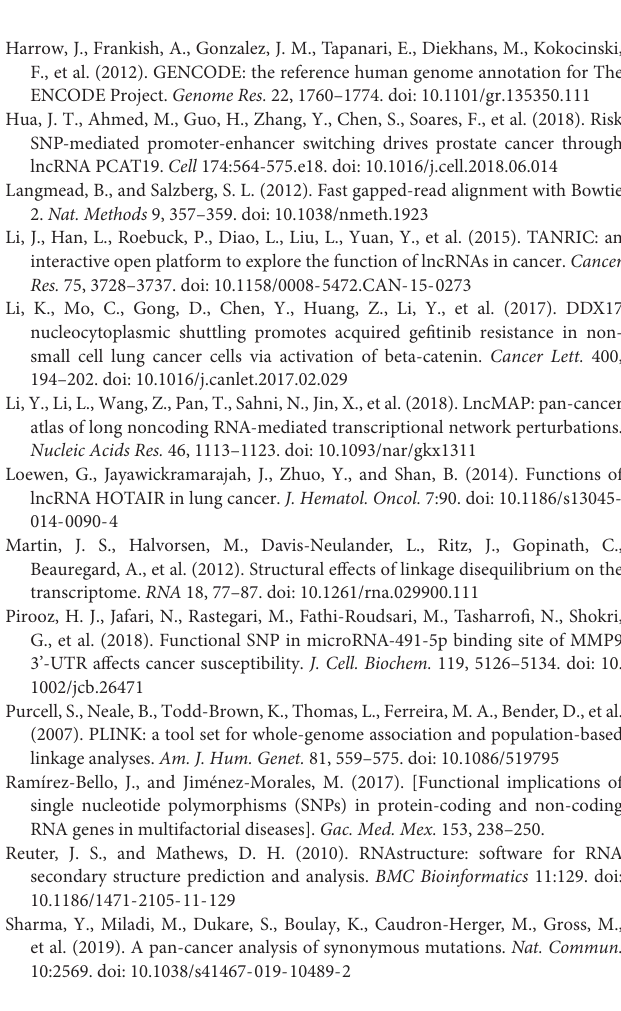
FIGURE S1 | The robust analysis of RNAsmc score. Blue and red lines indicate the differences between WT and MT lncRNA transcripts, respectively. FIGURE S2 | The permutation rules and significance evaluating of RS1, RS2, respectively. (A) Permutating flanking sequence in random way, and keeping WT and MT SNP allele unchanged. The sequence in blue shadow represented the changed content in RS1. (B) Building the background distribution for RS2. The base in red shadow showed it altered in each iteration. (C) The significance of lncRNA structural heterogeneity using RS1 and RS2. Red dot indicated that the changes were significant both in RS1 and RS2. TABLE S1 | LD SNPs mapping on lncRNA transcripts. TABLE S2 | The analysis of lncRNA structural heterogeneity induced by SNPs. TABLE S3 | The significance of lncRNA structural heterogeneity by RS1. TABLE S4 | The significance of lncRNA structural heterogeneity by